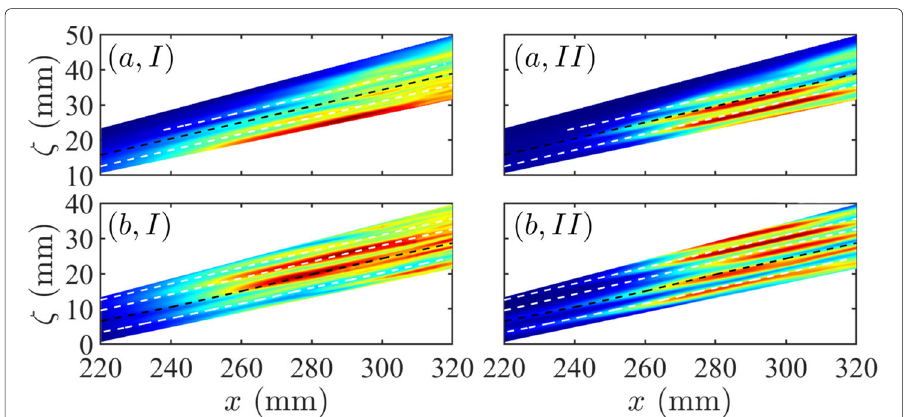
Fig. 8 The distribution of the r.m.s. (shaded contour) of the low- (10-50 kHz, I) and high-frequency (300-600 kHz, II) wall pressure and the wall heat flux (dashed lines) in the neighbourhood of stationary crossflow vortex trajectories V1 a and V2 b . Trajectories V1 and V2 are colored in